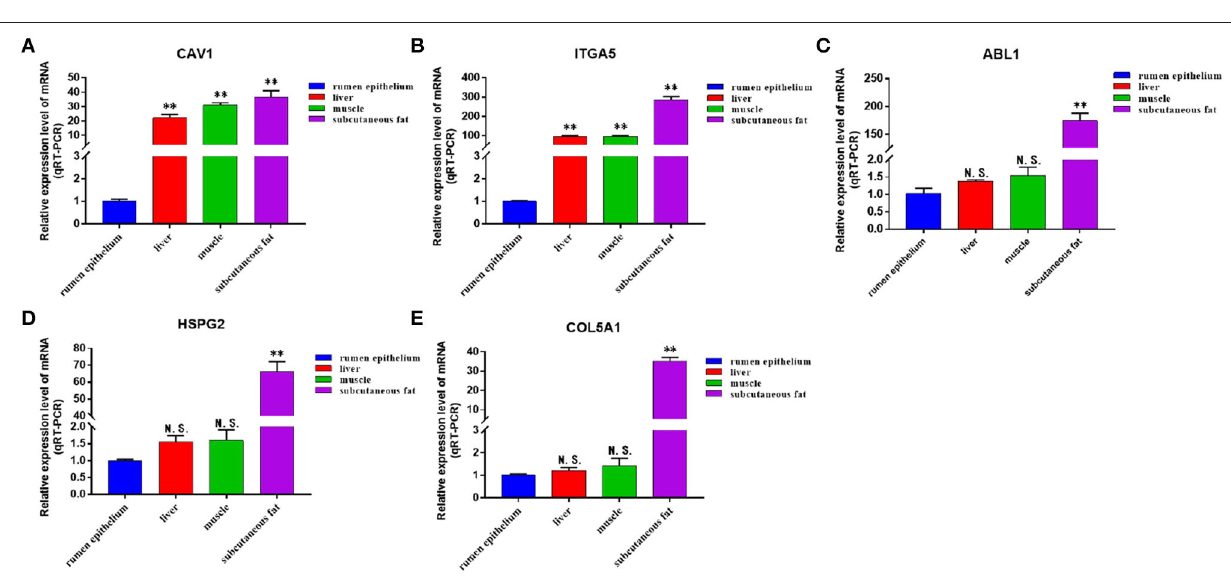
cell differentiation (37). Fatty acid binding protein 4